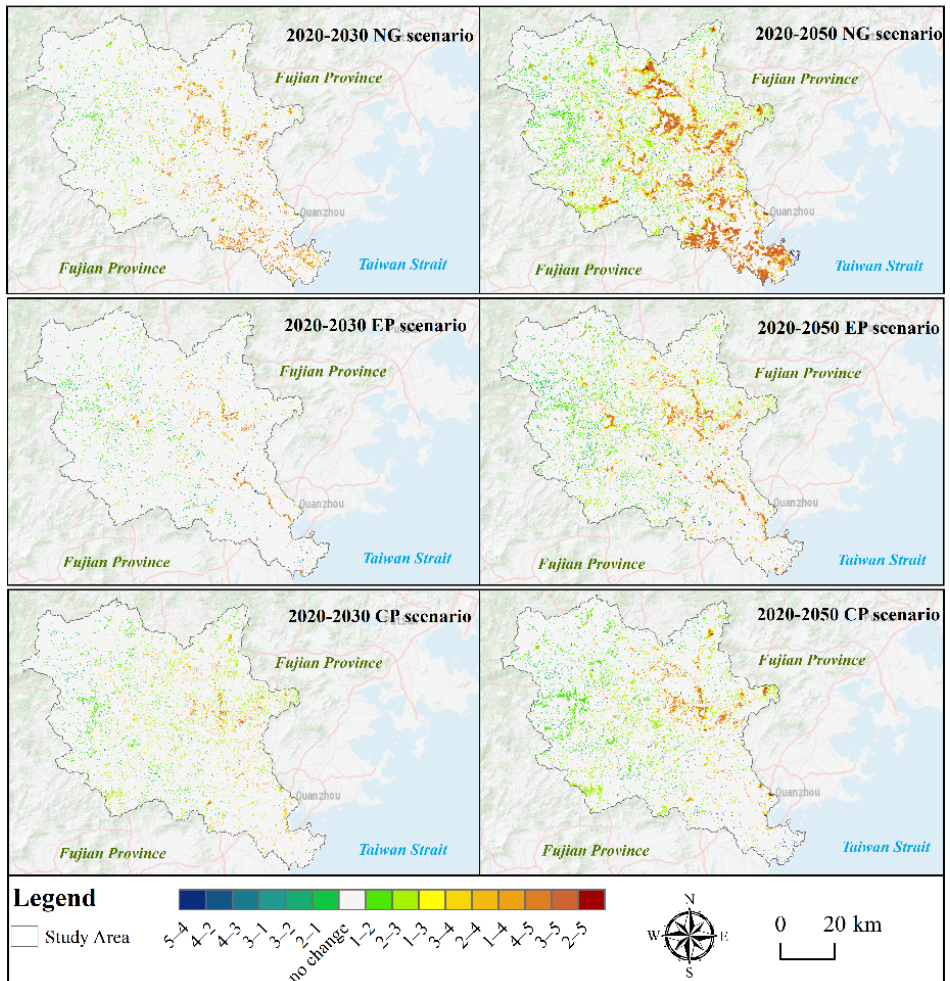
Figure 10. Dynamic changes in flood risk levels under three scenarios from 2020 to 2050 in the Jinjiang Basin. The Roman numerals from 1 to 5 represent very low, low, moderate, high, and very high, respectively. The Roman numeral on the left of “—” represents the flood risk level of 2020, while that on the right represents the year 2030 or 2050. NG, EP, and CP scenarios represent natural growth, ecological protection, and cropland protection scenarios, respectively.